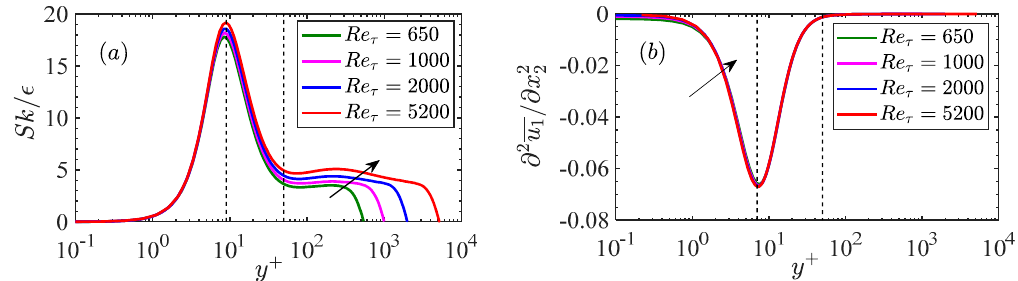
Figure 5. ( a ) Dimensionless shear parameter Sk / (cid:15) and ( b ) dimensionless quadratic mean velocity gradient d 2 u 1 / dx 2 as functions of dimensionless wall distance y + in channel flow at Re τ = 650, 1000, 2000 and 5200. (cid:1873)(cid:3364) (cid:2869) and is the axial mean velocity, and (cid:1876) (cid:2870) is the direction normal to the wall.